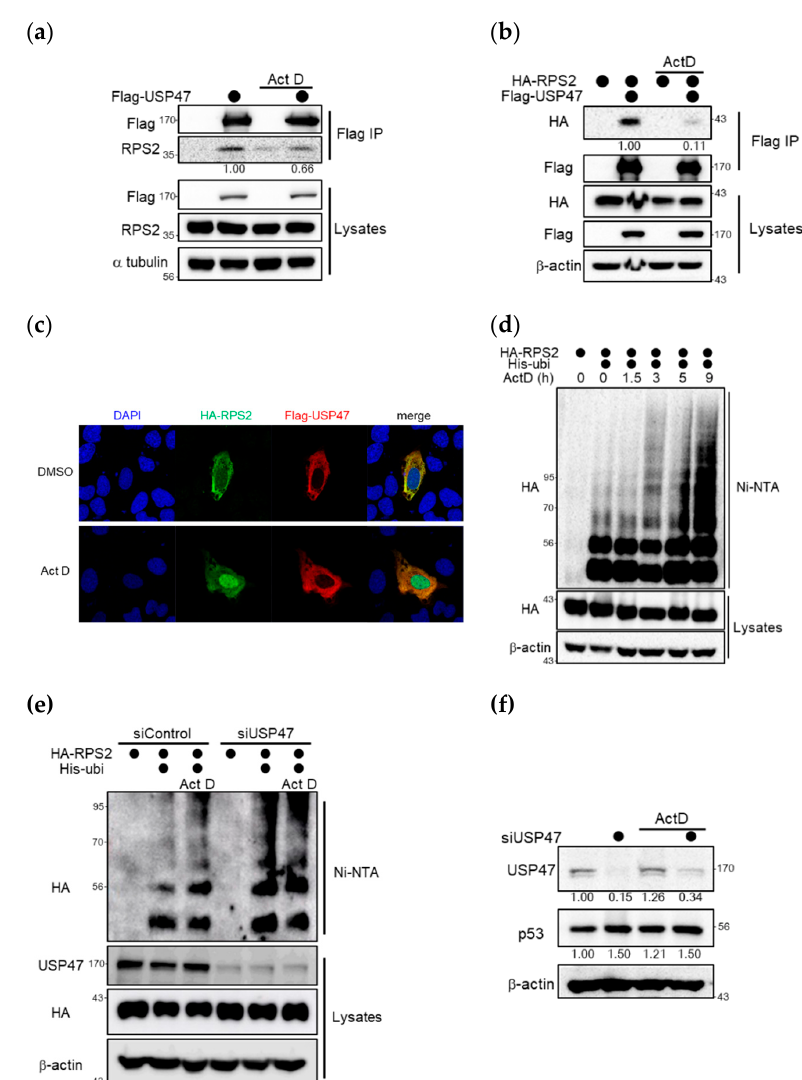
Figure 5. Ribosomal stress leads to RPS2 ubiquitination for MDM2 regulation to induce p53 by dissociation of USP47 and RPS2. ( a ) U2OS cells co-overexpressing either Flag vector or Flag-USP47 were treated with DMSO or 5 nM actinomycin D for 4 h, and immunoprecipitation was performed with anti-Flag agarose. Bound proteins were immunoblotted with the indicated antibodies. α -tubulin was used as a loading control. ( b ) HEK293T cells were co-overexpressed with HA-RPS2, Flag-USP47, and then treated with DMSO or 5 nM actinomycin D for 4 h. Then, cell lysates were immunoprecipitated with anti-Flag M2 agarose and detected with the indicated antibodies. ( c ) U2OS cells were co-overexpressed with Flag-USP47 and HA-RPS2 and then treated with DMSO or 5 nM actinomycin D for 4 h. Cells were immunostained with anti-HA antibody followed by Alexa Fluor 488 anti-mouse IgG and Flag antibodies followed by Alexa Fluor 546 anti-rabbit IgG. Representative immunofluorescence images were captured by confocal microscopy. ( d ) HEK293T cells were overexpressed with HA-RPS2 and His-ubiquitin and then treated with 10 μ M MG132 for 4 h and 5 nM actinomycin D for indicated times. Ubiquitin conjugates were purified on Ni-NTA-agarose under denaturing conditions, and ubiquitinated RPS2 was detected by anti-HA antibodies. ( e ) U2OS cells were co-transfected with His-ubiquitin, HA-RPS2, and either siControl or siUSP47 and then treated with 10 µ M MG132 and either DMSO or 5 nM actinomycin D for 4 h. Ubiquitin conjugates were purified on Ni-NTA agarose under denaturing conditions, and ubiquitinated RPS2 was detected by anti-HA antibodies. ( f ) U2OS cells transfected with siRNA against control or USP47 were treated with either DMSO or 5 nM actinomycin D for 4 h. Cell lysates were immunoblotted with the indicated antibodies. The uncropped blots and molecular weight markers are shown in Figure S7.